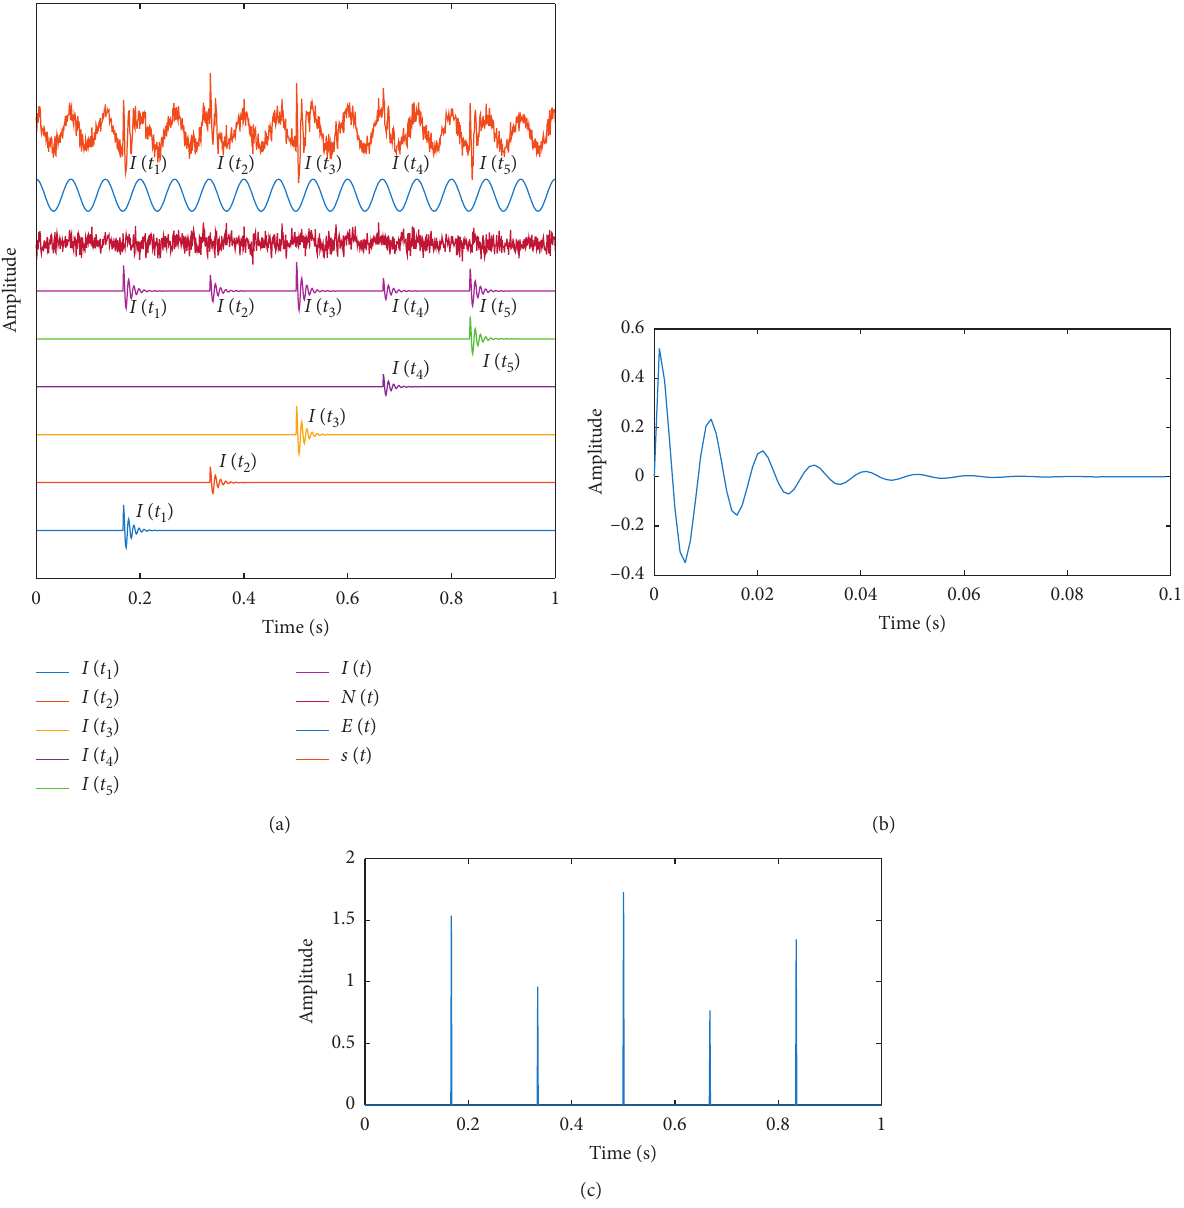
Figure 1: (a) Dynamic generating process of the impulses induced by faults; (b) shock responses; and (c) location